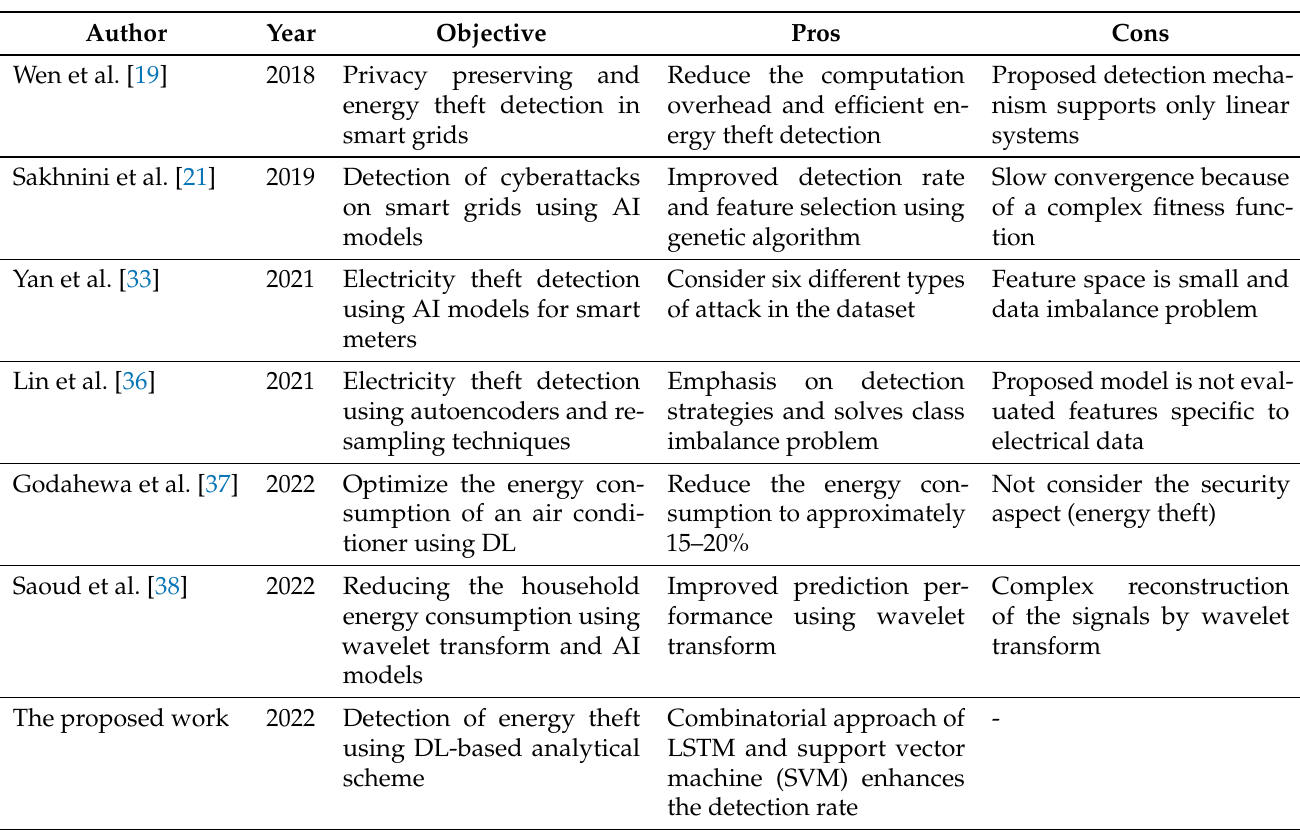
Table 2. Comparative analysis between existing state-of-the-art work with our proposed